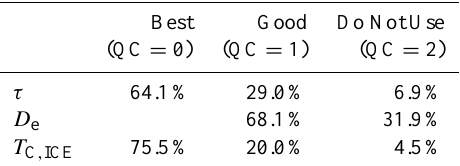
Table 4. Percent occurrence of the QC values (0, 1 or 2) for τ , D e , and T C , ICE for 2007. These percentages are from the subset of AIRS FOVs that contain ice (26.5% globally during this time